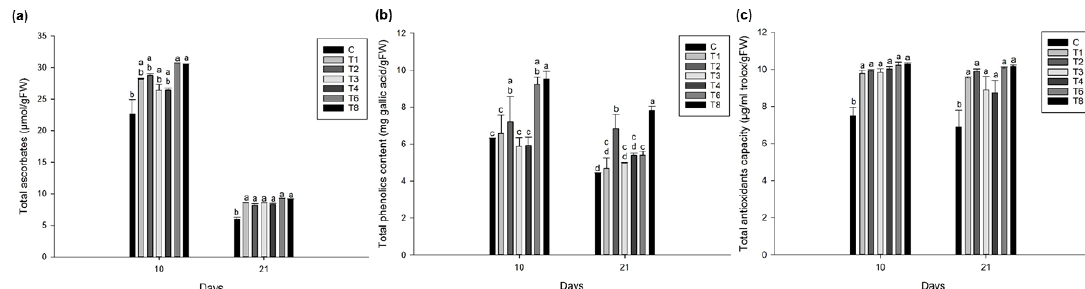
Figure 7. Effect of the preharvest treatment of ANE, HA, and different combinations of ANE + HA on ( a ) total ascorbates content, ( b ) total phenolics content, and ( c ) total antioxidant capacity of leaves of lettuce stored at 0–4 °C in the dark with RH ≥ 95% for 10 and 21 days after harvest. Different combinations of ANE and HA used for preharvest treatment were as follows: C (control), T1 (0.1% ANE), T2 (0.25% ANE), T3 (0.2% HA), T4 (0.4% HA), T6 (0.1% ANE + 0.4% HA), and T8 (0.25% ANE + 0.2% HA). Each experiment was performed in triplicate, and each experimental unit had six plants. The average of the eighteen values were presented as mean ± SE and means represented by same letters were not significantly different at p ≤ 0.05.